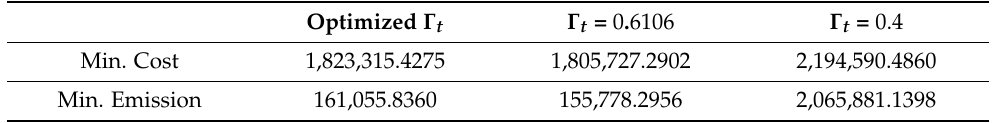
Table 10. Minimum cost and minimum emission for various values of Γ t .